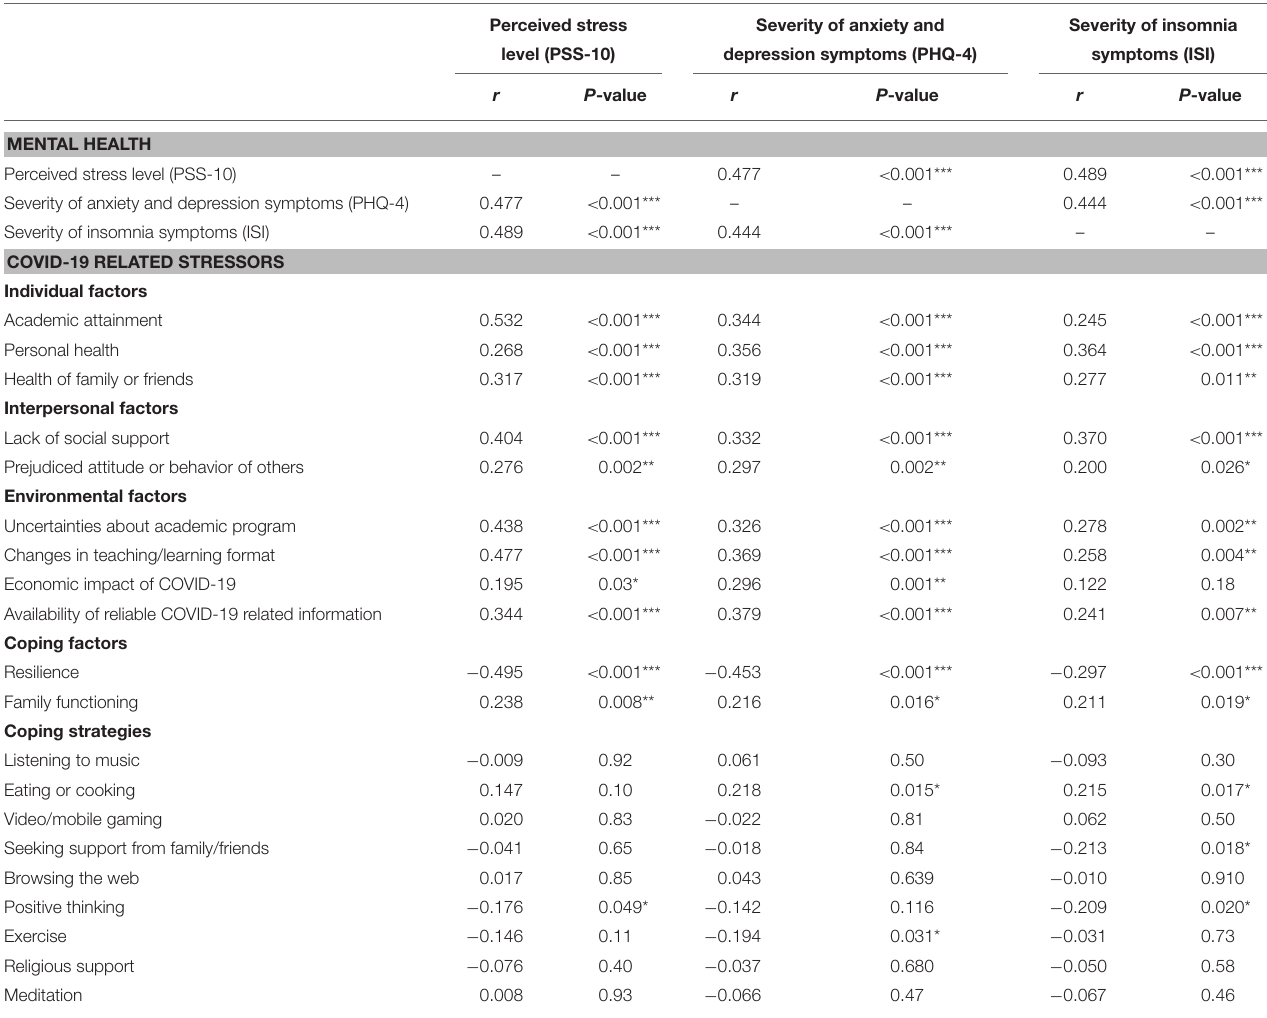
TABLE 4 | Association between mental health impacts and coronavirus disease 2019 (COVID-19)-related stressors, coping factors, and